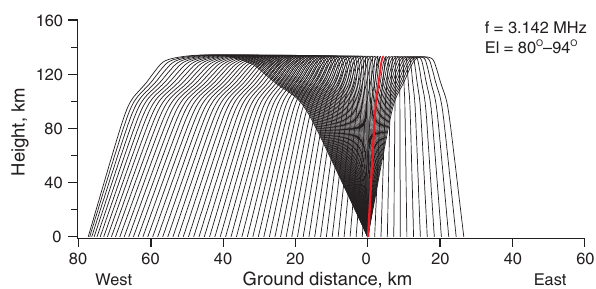
Figure 8. Ray plots for initial elevation angles from 80 to 94 ◦ with increments of 0.2 ◦ at a frequency of 3.142MHz. Red line shows a ray path that returned to the receiver (ionosonde).